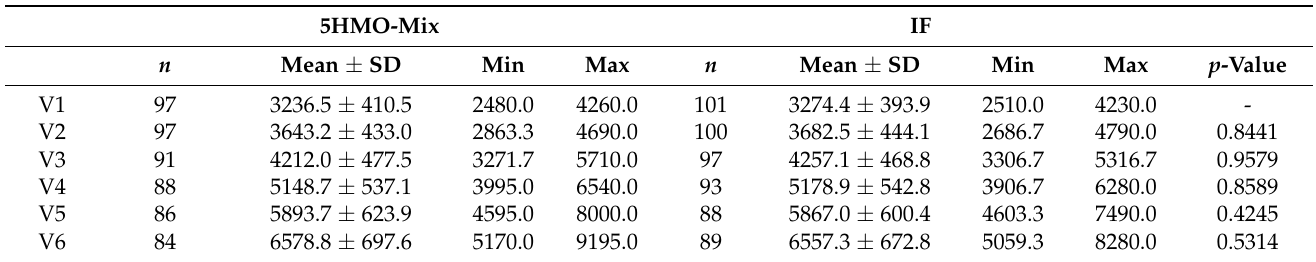
Table 3. Average body weight (g) at V1, V2, V3, V4, V5, and V6 for the two intervention groups. Data shown for subjects with values at V1 and at the actual visit were included in the analysis. ANCOVA with the fixed effect factors “treatment”, “site”, and “sex” and body weight at V1 as covariate was used for the statistical analysis (observed cases,